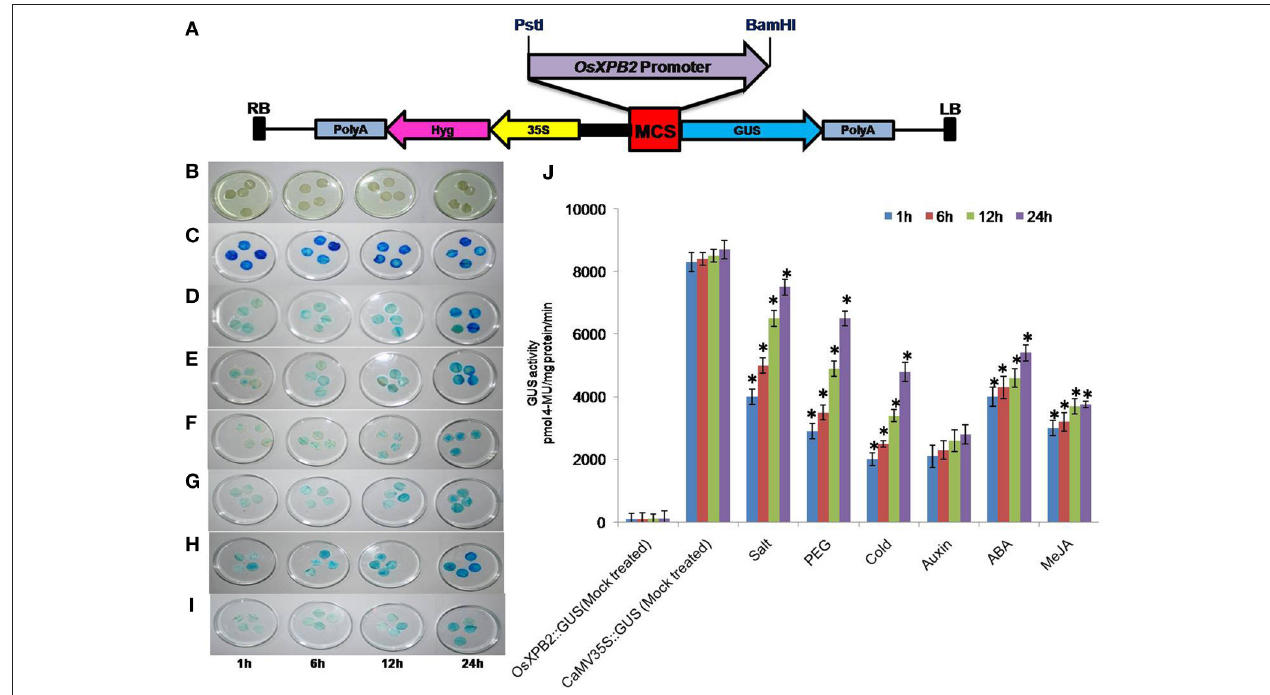
FIGURE 1 | (A) Schematic representation of OsXPB2 promoter cloned in pCAMBIA1391Z vector (promoter less vector) at PstI and BamHI sites for measuring GUS activity and agro-infiltration. (B–J) time course of OsXPB2 promoter- GUS expression analysis in the agro-infiltrated tobacco leaves in response to abiotic stress [200mM salt, 20% PEG, cold (4 ◦ C) stress] and phytohormones [MeJA (10 µ M), ABA (5 µ M), and auxin (10 µ M)]. Histochemical GUS staining of OsXPB2 promoter::GUS treated with water (mock treated) (B) , CaMV35S ::GUS water (mock treated) (C) , OsXPB2 ::GUS NaCl (D) , PEG (E) , cold (F) , Auxin (G) , MeJA (H) , ABA (I) , comparison of GUS activity determined in protein extracts ( in vitro ) (J) . Data of four independent agro-infiltrated leaves were measured, and each experiment was replicated four times. Error bars on the graphic represent ( ± SD). * P < 0.05 differ significantly from their respective controls according to Student’s paired t